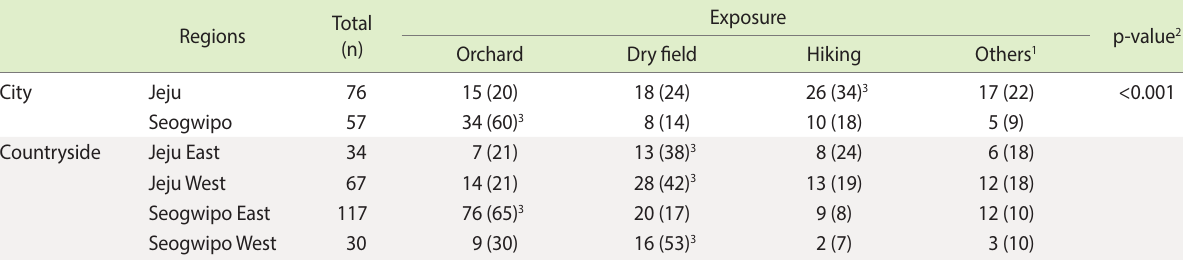
Table 3. Exposure that may cause scrub typhus by region